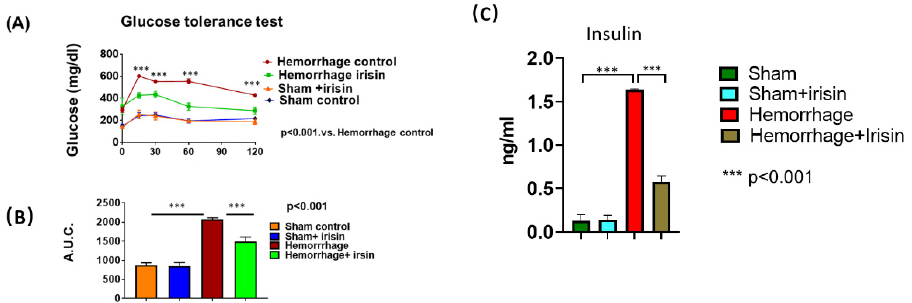
Figure 3. Glucose tolerance test and insulin measurement. Mice fasted 6 h before glucose tolerance test. ( A ) Time dependent glycemic levels post glucose injection (1.5 g/kg body weight of glucose was administered intraperitoneally. Data are shown as Mean ± SEM, n = 5/each group, *** p < 0.001); ( B ) A bar graph for blood glucose area under the curve analysis from GTT (Data are shown as Mean ± SEM, n = 5/each group, *** p < 0.001); ( C ) The measurement of insulin level in serum among the groups (Data are shown as Mean ± SEM, n = 5/each group, *** p <